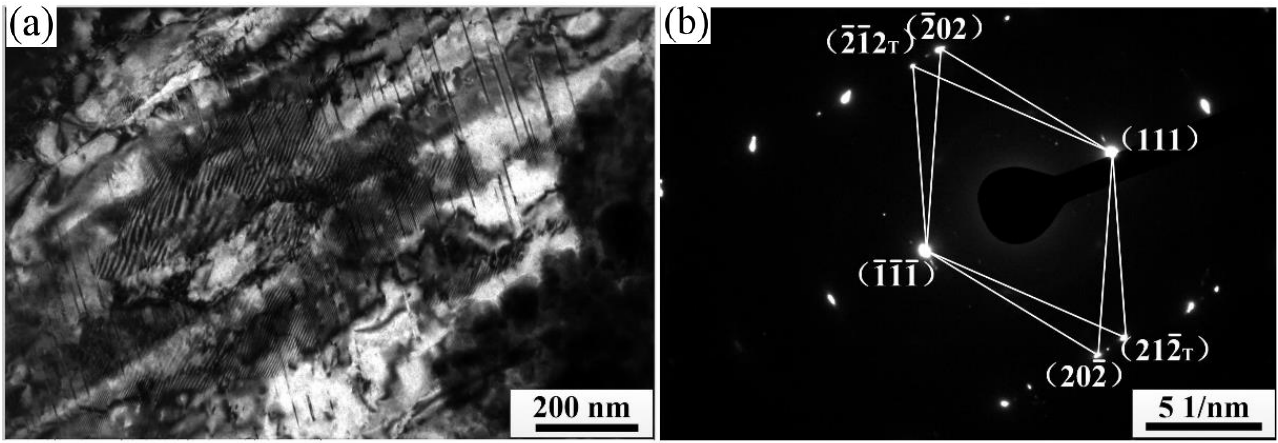
Figure 10. Deformation twin structure in cold rolled EG strip (ε = 75%). ( a ) Deformation twin and ( b ) Corresponding selected electron diffraction pattern.